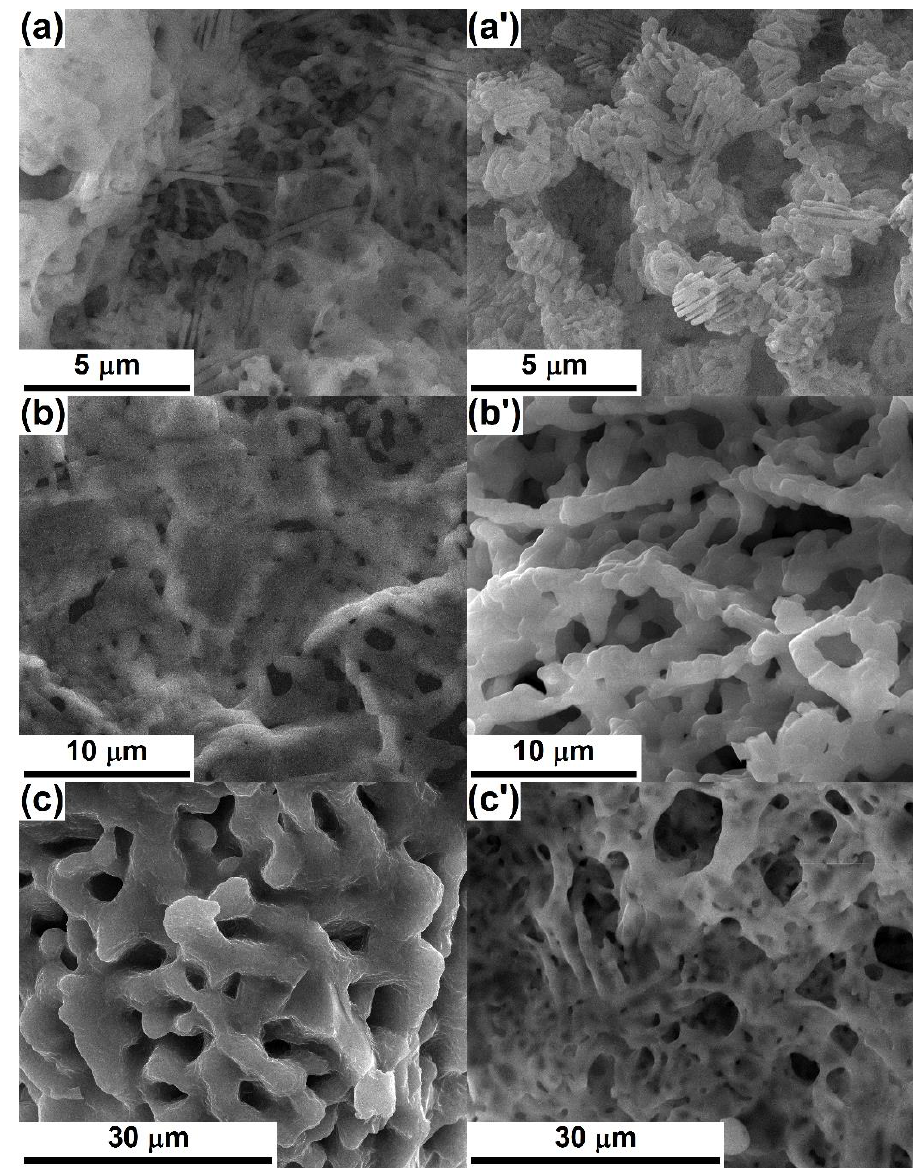
Figure 6. SEM images of Gel -CPs-3c composite thermally treated at: ( a ) 800 °C, ( b ) 1000 °C, and ( c ) 1200 °C and Gel -CPs-BT-3c composite thermally treated at ( a ’) 800 °C, ( b ’) 1000 °C, and ( c ’) 1200 °C.